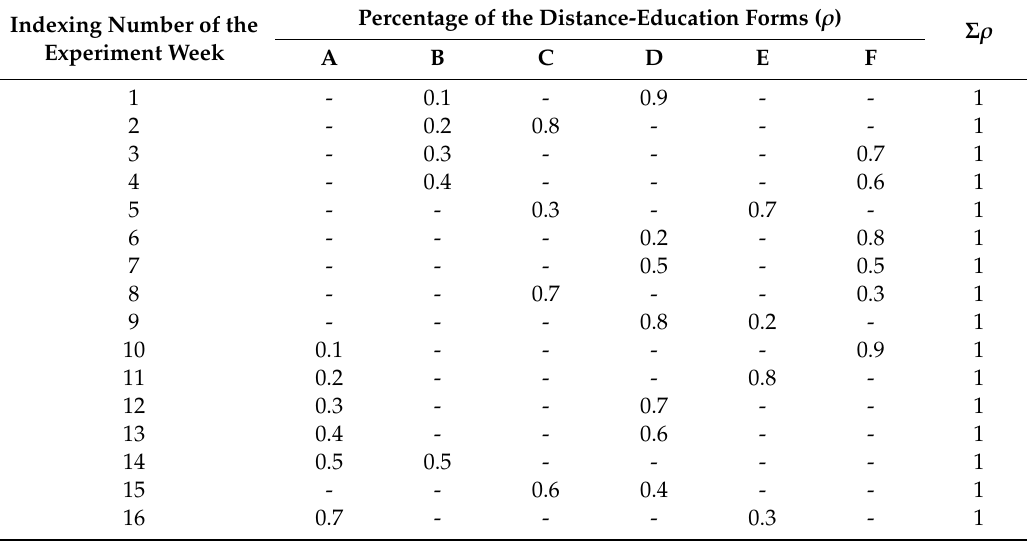
Table A1. Schedule for conducting an experiment to improve the distance-learning e ff ectiveness at the university: a case study of learning the discipline “Theoretical Foundations of Electrical Engineering”. Indexing Number of